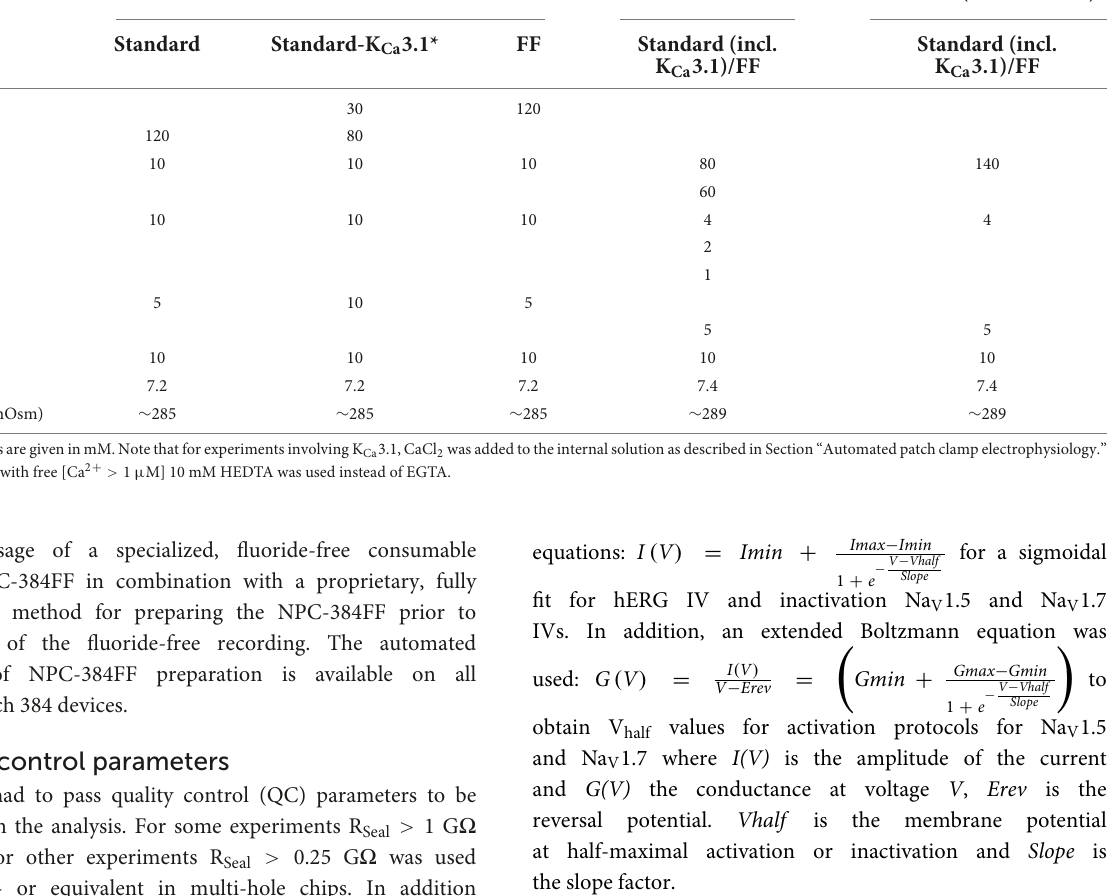
TABLE 1 Composition of recording solutions for fluoride-containing (referred to as standard internal) and fluoride-free (referred to as FF internal) experiments. Constituent Internal recording